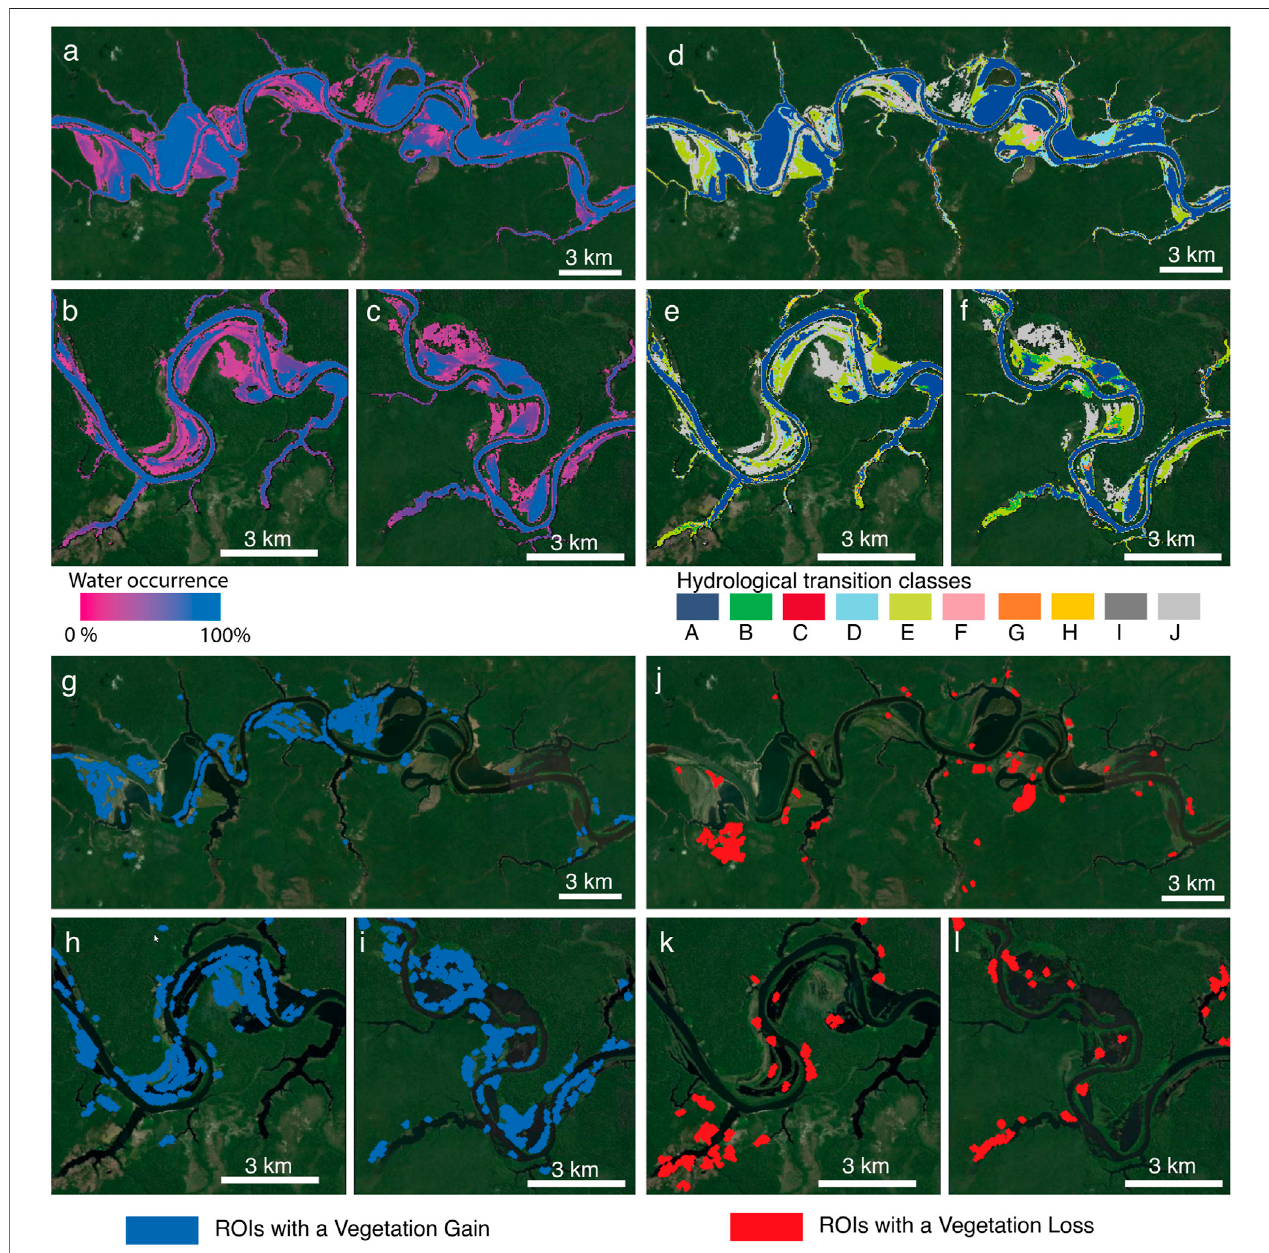
FIGURE 8 | Alteration in the hydrological conditions of study area. a-c Frequency of water presence from 1984 to 2020. d-f Maps of hydrological transition occurred between 1984 and 2020; (A) : unchanging permanent water surfaces; (B) : new permanent water surfaces (conversion of land into permanent water); (C) : lost permanentwatersurfaces(conversionofpermanentwaterintoland); (D) :unchangingseasonalwatersurfaces; (E) :newseasonalwatersurfaces(conversionoflandinto seasonal water); F: loss of seasonal water surfaces (conversion of a seasonal water into land); (G) : the conversion of seasonal water into permanent water; (H) : conversion of permanent water into seasonal water; (I) : ephemeral permanent water (land replaced by permanent water that subsequently disappears) J: ephemeral seasonal water (land replaced by seasonal water that subsequently disappears). For further details about frequency of water presence and de fi nition of hydrological transition classes refer to Pekel et al. (2016). (G-I) ROIs with a vegetation gain detected by using NDVI index. (J-L) ROIs with a vegetation loss detected by using NDVI index. For graphical reasons, only the some reaches of the area of study are here reported. The whole region and results of all vegetation indices are reported in the Supplementary Figure S3-S8